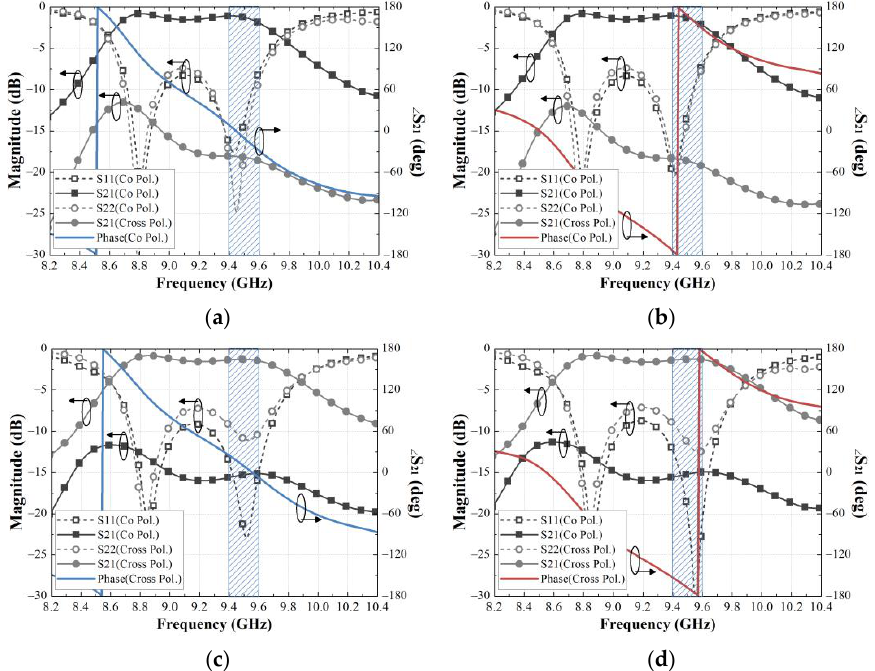
Figure 4. Simulated performance of the proposed unit-cell with changes of diode state: ( a ) State 1 (Pol.: V, Phase: 0°); ( b ) State 2 (Pol.: V, Phase: 180°); ( c ) State 3 (Pol.: H, Phase: 0°); ( d ) State 4 (Pol.: H, Phase: 180°). Table 2. Simulated performance of the proposed unit-cell (Freq. at Min. insertion loss).